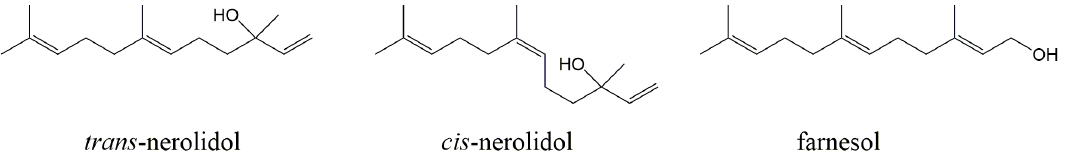
Figure 1. Structural formulae of used sesquiterpenes, trans -nerolidol, cis -nerolidol, and farnesol.